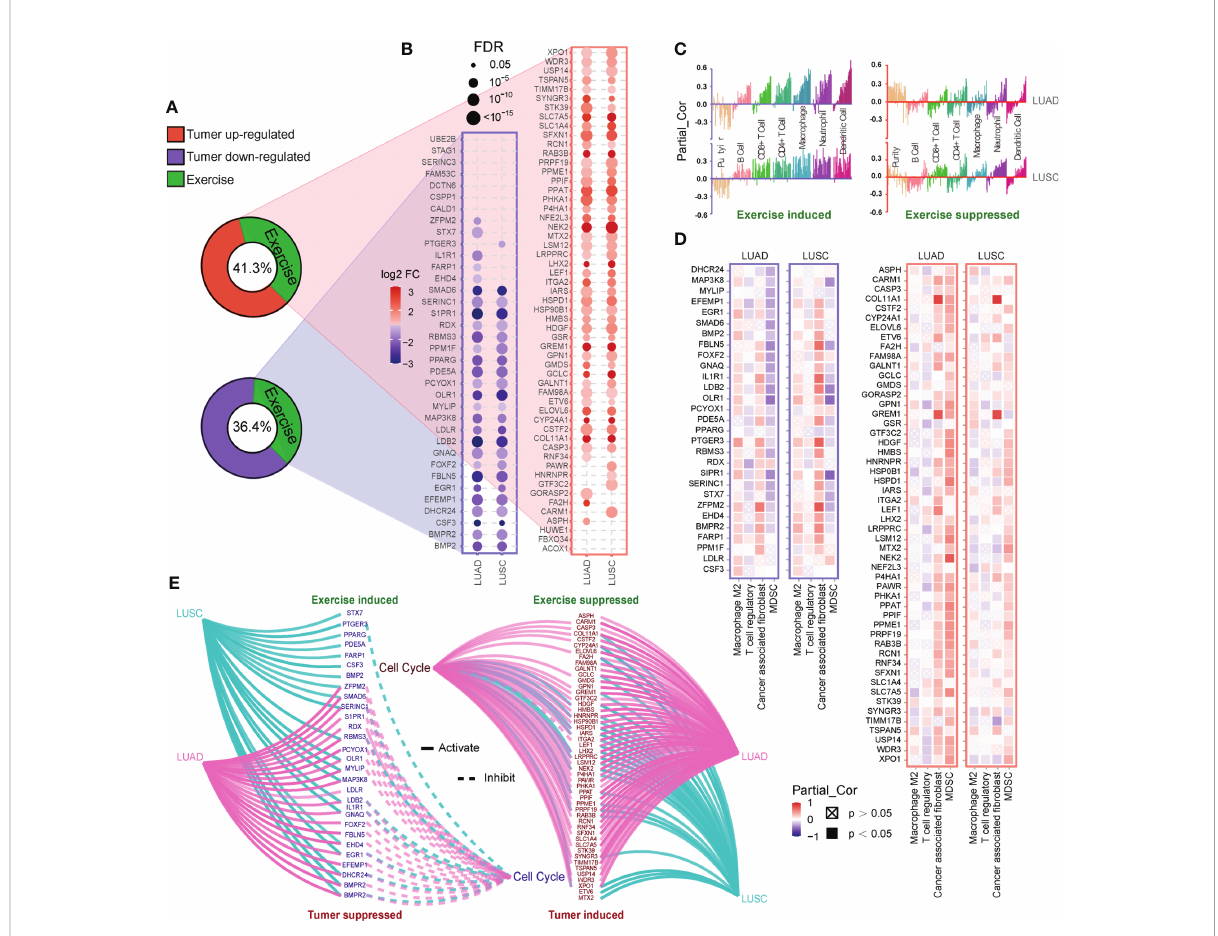
FIGURE 4 Functional analysis of co-target genes. (A, B) Based on the revers analysis function of RNCORI, 41.3% up-regulated and 36.4% down-regulated target genes of LC-associated miRNA (A) could be inversely regulated by exercise-associated miRNAs (green). And these co-target genes (B) were veri fi ed by the mRNA expression module of GCSALite based on TCGA expression data (LUAD and LUSC). (C, D) The correlations between co-target genes and in fi ltration of six immune cell types (C) and four immunosuppressive cell types (D) in LUAD and LUSC were shown. Every bar in (C) represents a co-target gene. The correlations were depicted by purity-corrected partial Spearman ’ s rho values (Partial_Cor) through TIMER 2.0. (E) The activity of co-target genes in cancer-related cell cycle pathway was de fi ned and presented by the pathway activity module of